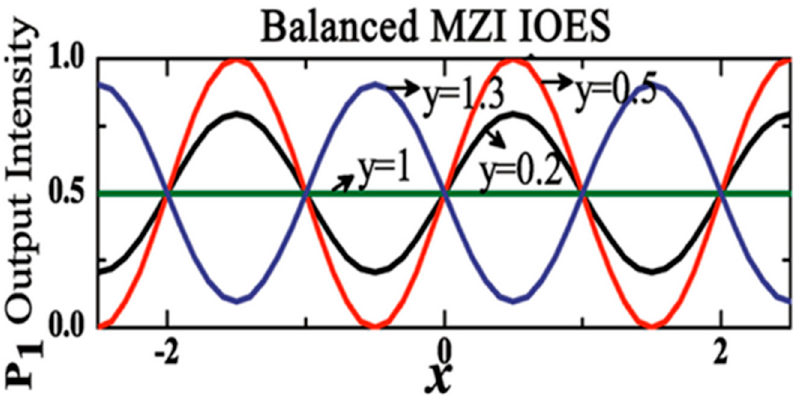
Figure 2. Simulation results for the light output intensity versus driving voltage with y = 0.2, 0.5, 1, and 1.3.